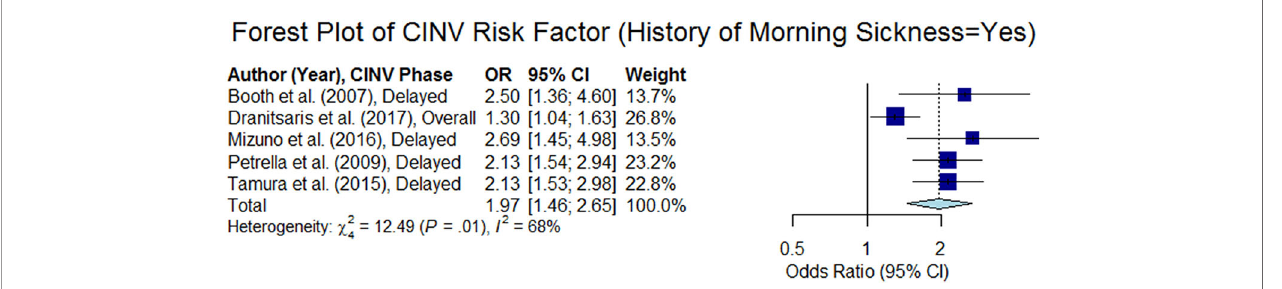
FIGURE 7 | Forest plot of Chemotherapy-Induced Nausea and Vomiting (CINV) risk factor (history of morning sickness